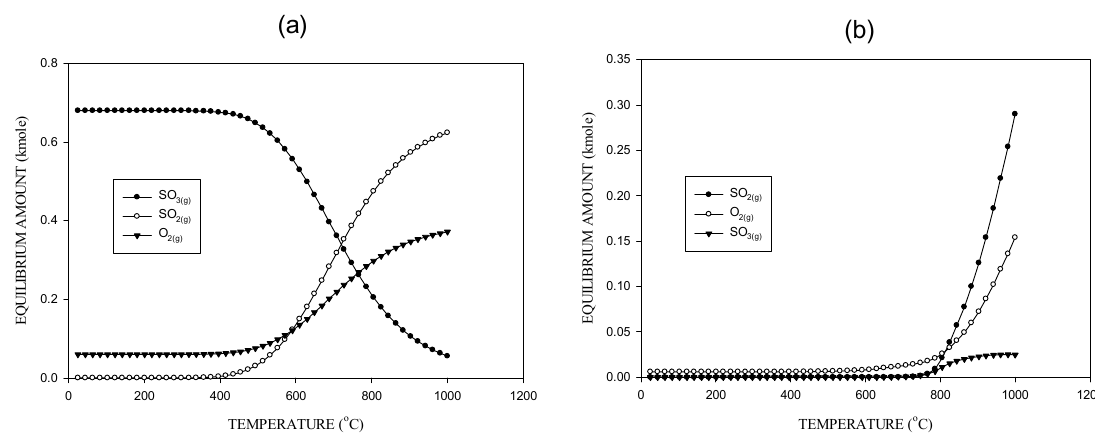
Figure 9. ( a ) Equilibrium amounts of the gaseous species as a function of temperature in the absence of the condensed phases for a sulphur dioxide addition of 0.68 kmole/100 kg of dust and an oxygen addition of 0.4 kmole/100 kg of dust. ( b ) Equilibrium amounts of the gaseous species as a function of temperature in the presence of the condensed phases for a sulphur dioxide addition of 0.68 kmole/100 kg of dust and an oxygen addition of 0.4 kmole/100 kg of dust.